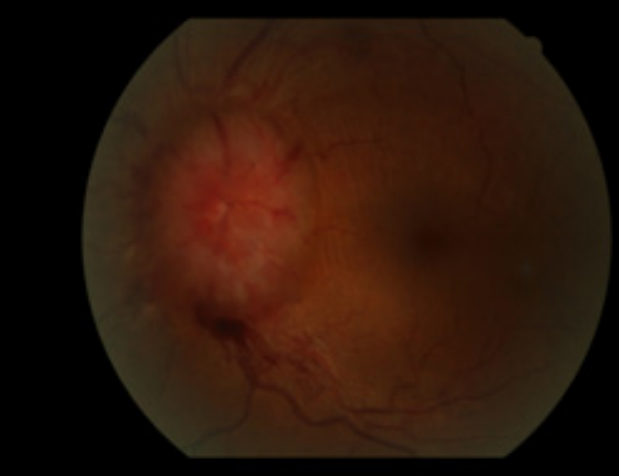
Figure 2 Patient GF: Left swollen disc with larger inferior haemorrhage (Fundus photograph by KC